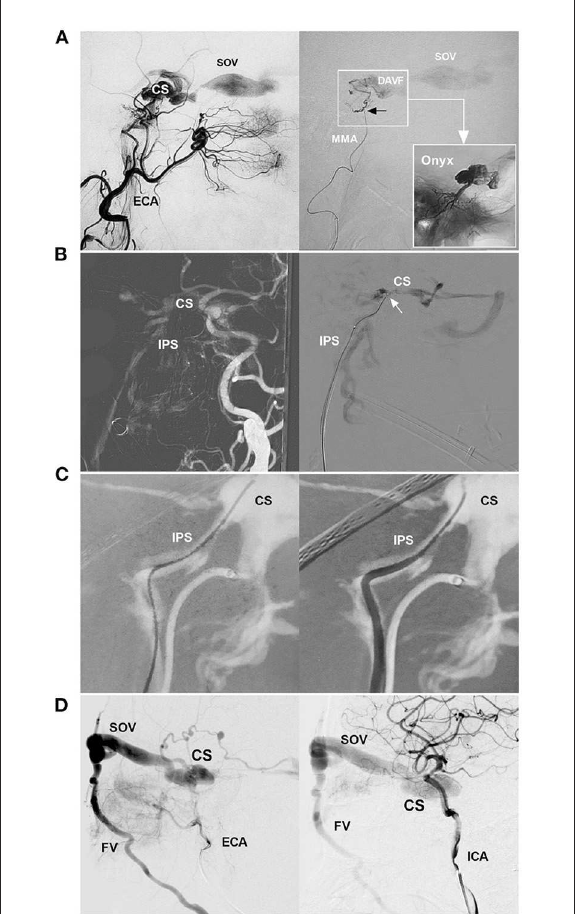
FIGURE1 EVT routes of CS-DAVF. (A) EVT for CS-DAVF via the MMA. Left: angiography of the ECA shows the CS-DAVF draining into the SOV; Right: superselective angiography of the MMA confirmed that the microcatheter obtained a wedged position (black arrow) and accessed the fistula (frame); the picture in a picture (right arrow) shows the casting of Onyx in the CS. (B) EVT for CS-DAVF via IPS. Left: Navigation image of the road map shows that the CS-DAVF drained into the IPS; Right: Superselective angiography confirmed that the microcatheter (arrow) was positioned in the CS. (C) Catheterization via IPS. Navigation image of the road map shows the guidewire into the CS via the IPS (left); then, the catheter went into the IPS following the guidewire (right). (D) CS-DAVF with the SOV as the main draining vein. Angiographies of the ECA (left) and ICA (right) show a CS-DAVF drained via the SOV and then to the FV. The CS-DAVF was appropriated for the trans-FV-SOV route to perform EVT. CS, cavernous sinus; DAVF, dural arteriovenous fistula; ECA, external carotid artery; EVT, endovascular treatment; FV, facial vein; ICA, internal carotid artery; IPS, inferior petrous sinus; MMA, middle meningeal artery; SOV, superior ophthalmic